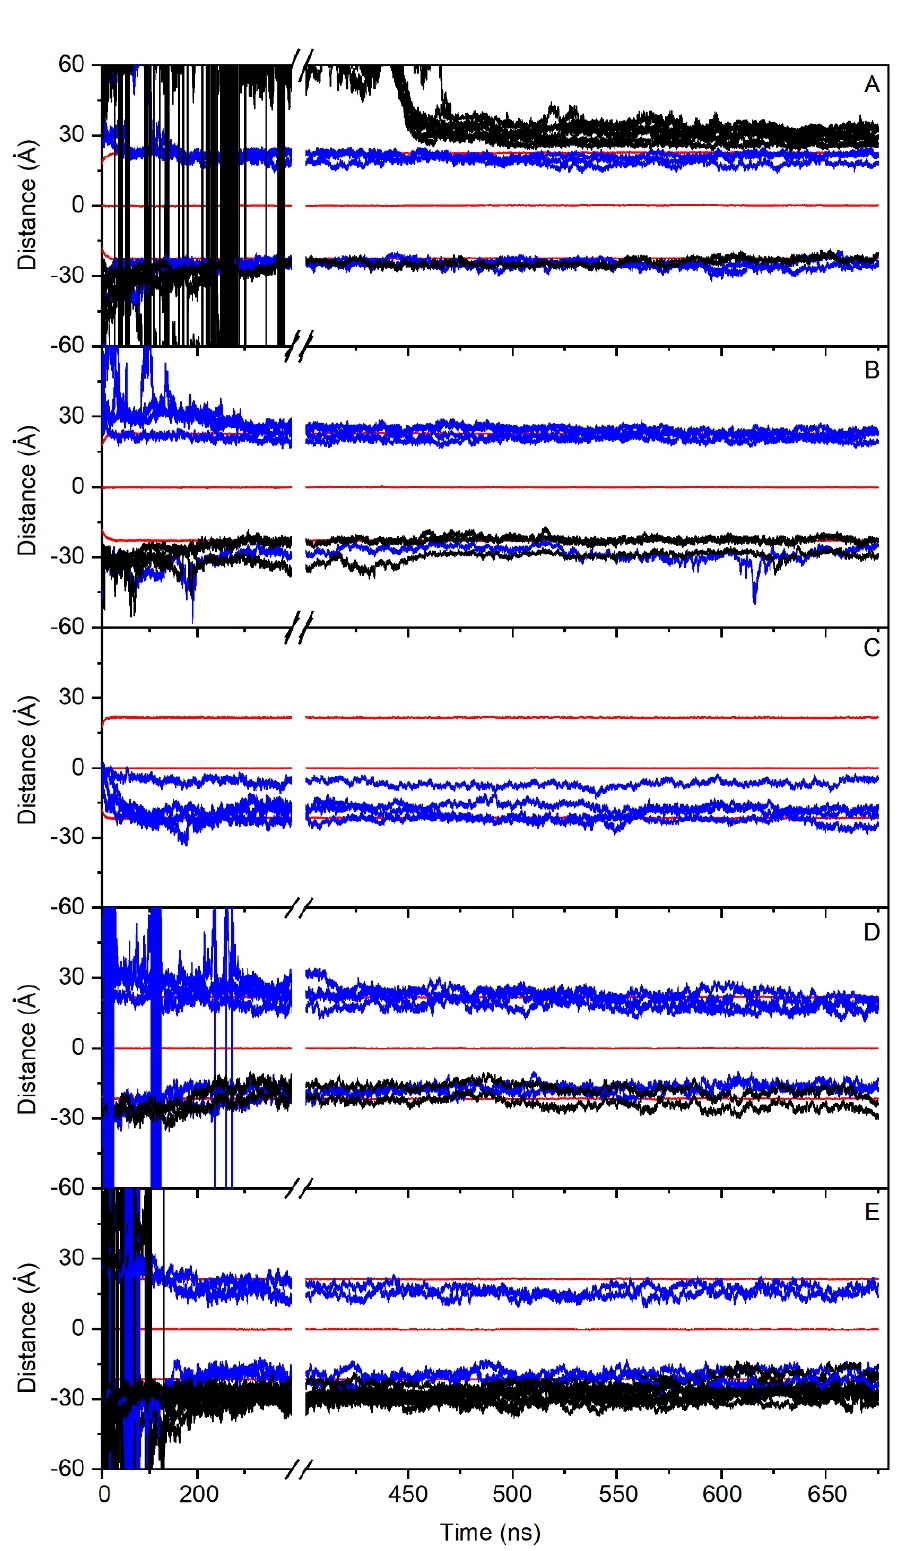
Figure 2. Time variation of the z -axis distance (middle of the membrane as a reference) for the different PC1 molecules in ( A ) system 1 (16 molecules), ( B ) system 2 (8 molecules), ( C ) system 3 (4 molecules), ( D ) system 4 (8 molecules), and ( E ) system 5 (16 molecules). PC1 molecules in the monomer state are depicted in blue, whereas the PC1 molecules forming dimers or higher-state oligomerization are depicted in black. The z -axis distance of the phosphate atoms of the phospholipids, defining the membrane surface, is depicted in red (upper, center, and lower boundaries). See text for details.